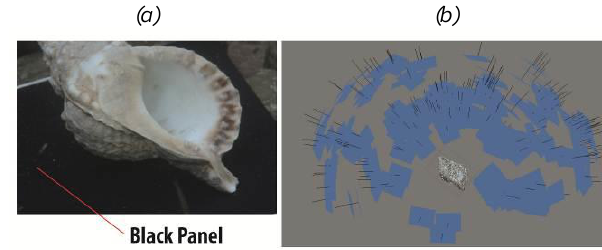
Figure 5. (a) Black panel used as background, (b) Network configuration of camera station for “underwater”